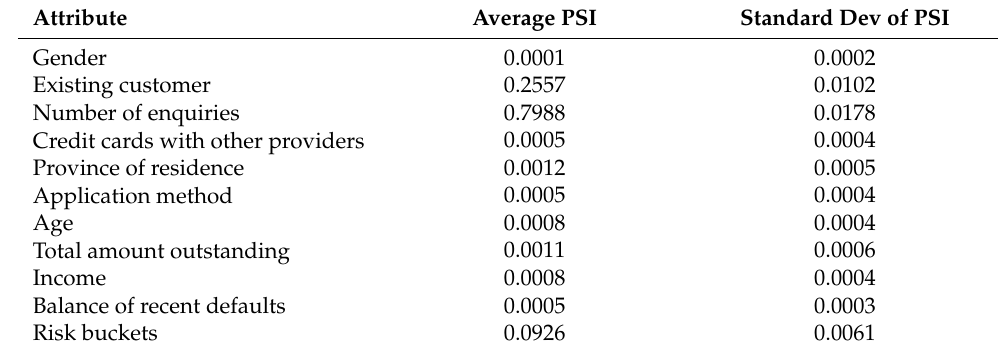
Table 9. Population stability